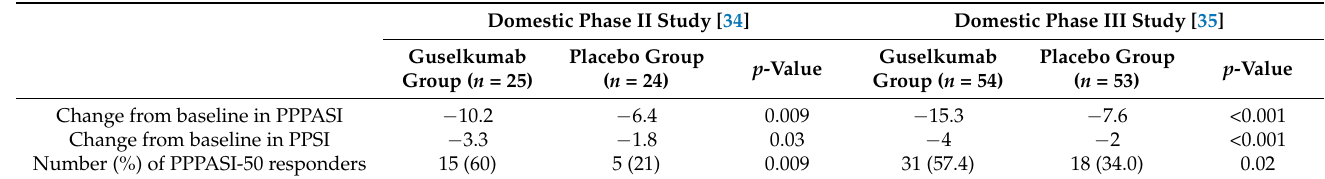
Change from baseline in PPPASI − 10.2 − 6.4